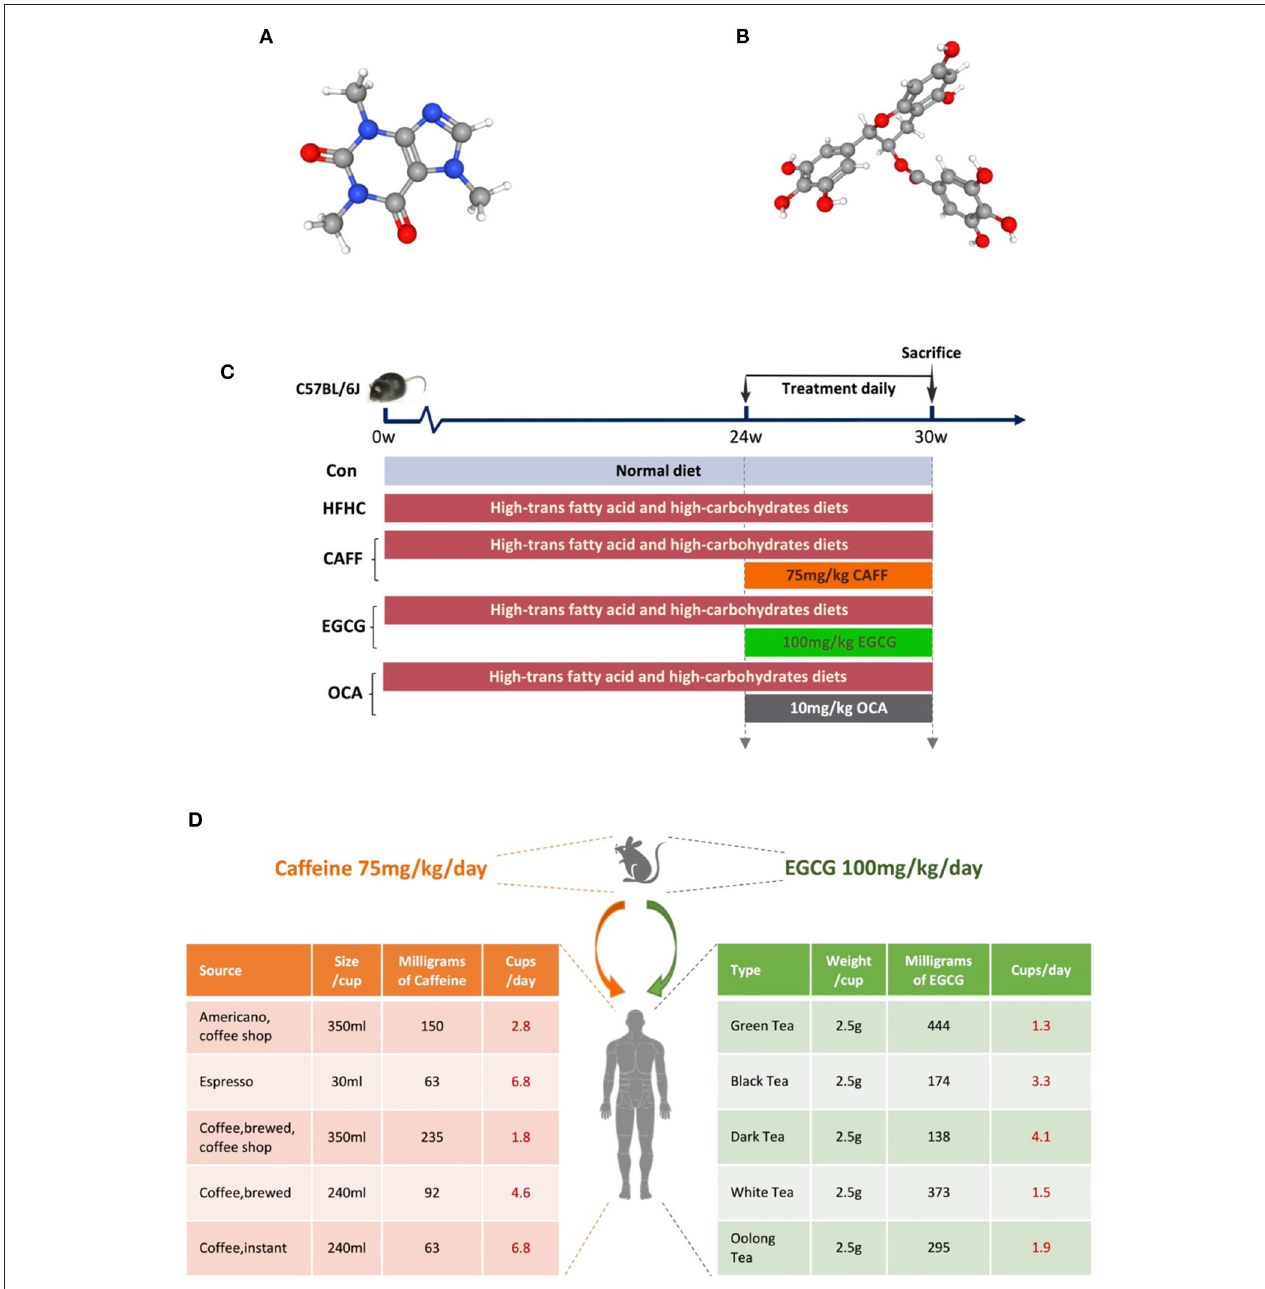
FIGURE 1 | Experimental drugs and flow chart of animal experiment. (A) The chemical structure of caffeine. (B) The chemical structure of (-) Epigallocatechin gallate. (C) The schedule of NASH model modeling and treatment, including the type of diet and the time and dose of treatment intervention. (D) The doses of caffeine and EGCG mice were equivalent to the number of coffee or tea cups consumed by humans according to the body